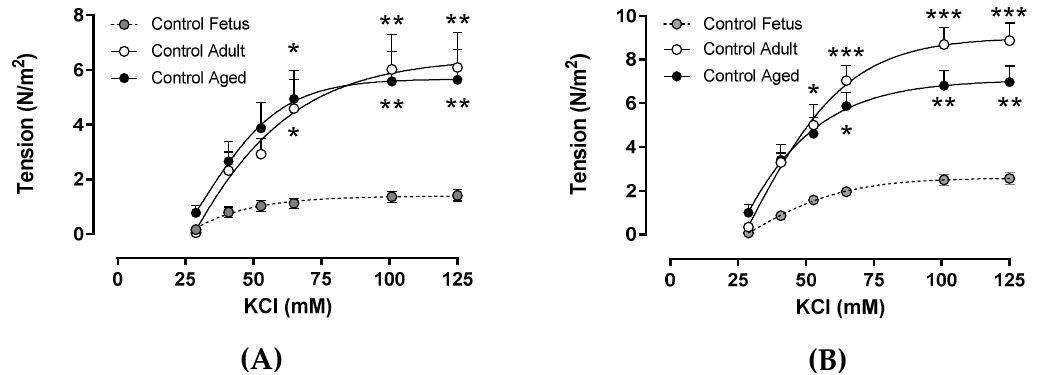
Figure 1. Ex vivo contractile response to KCl in arteries from fetal to aged guinea pigs. Concentration-dependent tension to KCl in carotid ( A ) and femoral arteries ( B ) from control fetus (gray circles, dashed black lines), control adult (open circles, continuous black lines), and control aged guinea pigs (solid circles, continuous black lines). Values are expressed in mean ± SEM. * p < 0.05, ** p < 0.01, *** p < 0.001 vs term fetus. Two-way ANOVA.